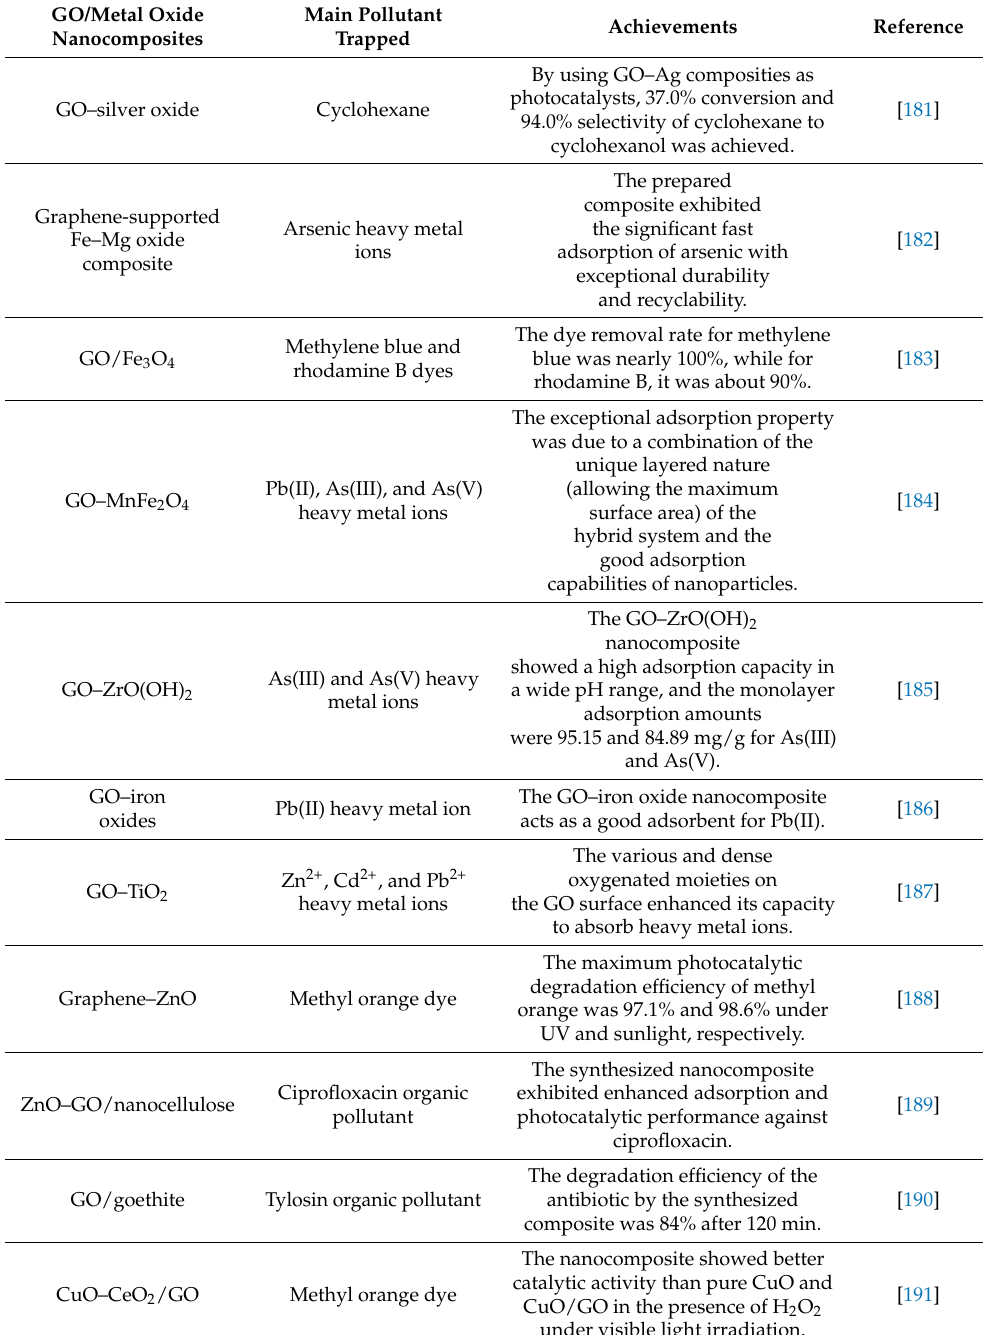
Table 6. Some recently published studies on GO–metal oxide nanocomposites and major pollutant trapped for environmental